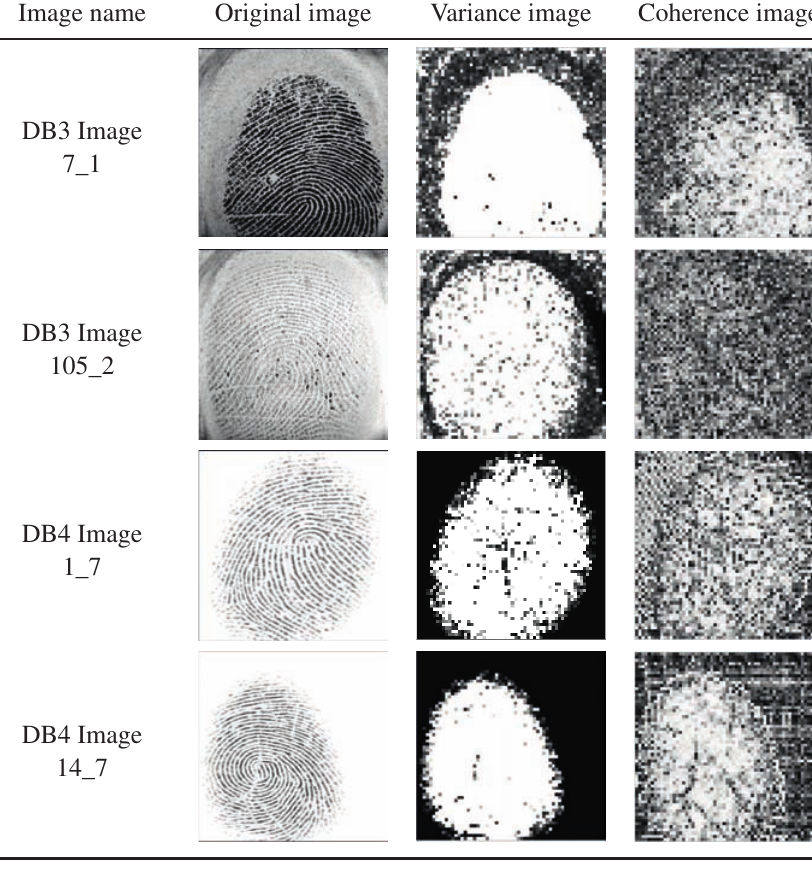
Table 1. A comparison between the variance and the coherence of